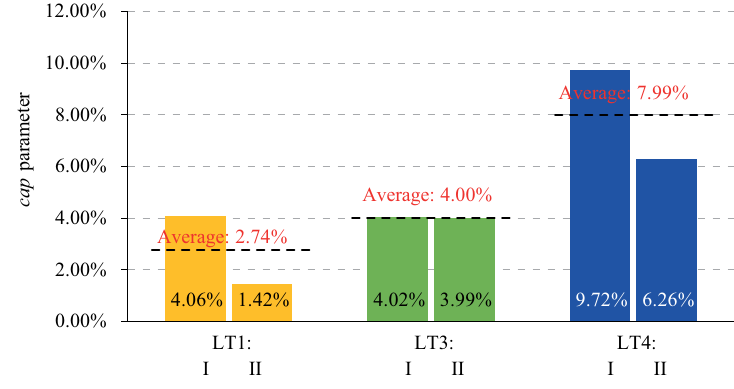
Figure 4. Comparison of altitude and cap parameter in